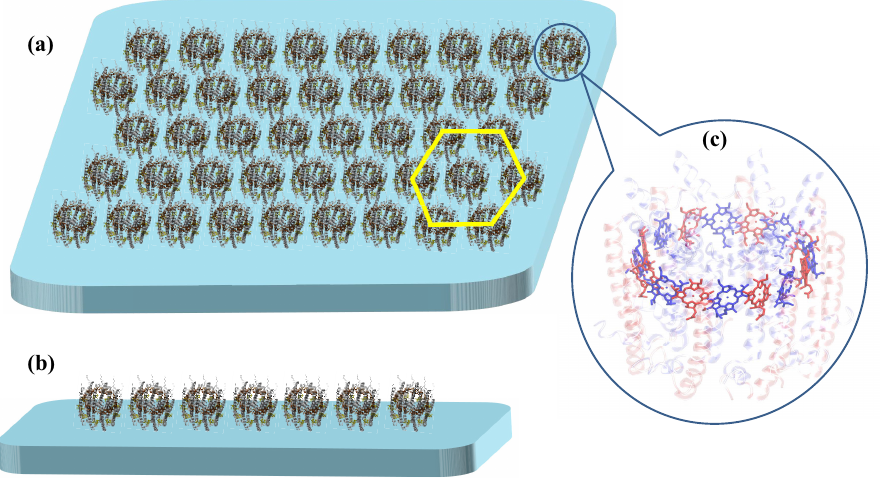
Figure 1. Schematic representation of the B850 nanoarrays used in this work to investigate the excitation energy migration: ( a ) two-dimensional (2D) and ( b ) one-dimensional (1D) B850 nanoarrays. The distance between adjacent B850 rings is 8 nm and each B850 ring is surrounded with six rings in the 2D nanoarray (as illustrated with the yellow hexagon in ( a )). The arrangements of the bacteriochlorophyll a (BChl a ) molecules in the B850 ring are illustrated in ( c ) with the proteins shown in transparent. The coordinates are extracted from the crystal structure of the LH2 complex (PDB ID: 1LGH) [41]. The α and β pigments are colored blue and red,